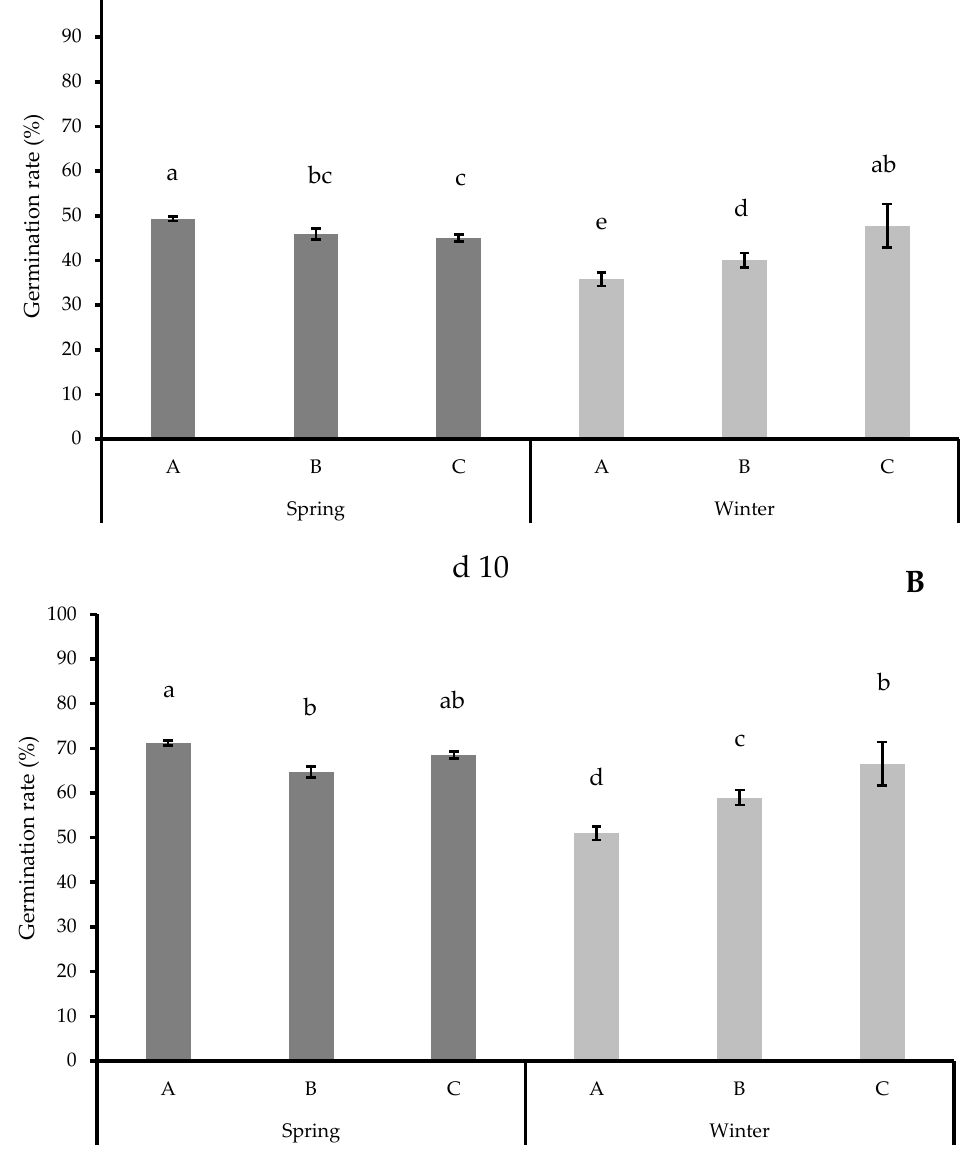
Figure 2. Camelina germination percentage (%), surveyed at 4 ( A ) and 10 days ( B ) after stress imposition, in response to the interaction biotype (winter vs. spring) × seed weight class ((A) TSW > 1.27 g vs. (B) 0.98 g < TSW < 1.27 g vs. (C) TSW < 0.98 g). Mean values ± SE. Different letters: statistically different means for P ≤ 0.05 (LSD’s test).